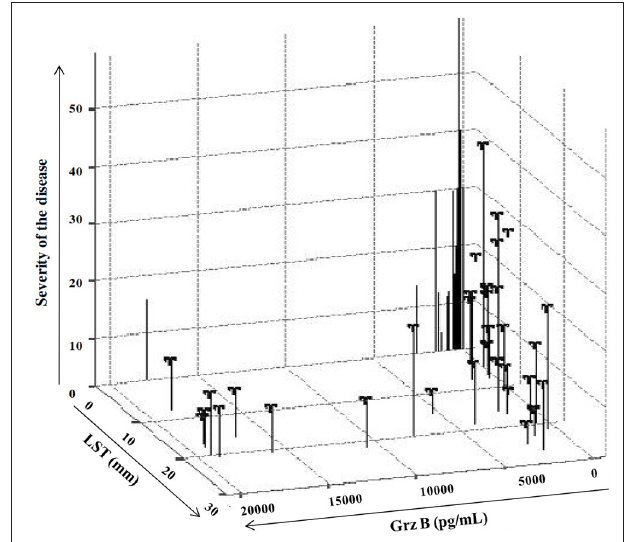
FIGURE 6 | Impact of the host’s immune response on the prevalence of ZCL. Expression of severity score in function of result of LST reactivity, expressed as diameter of induration (mm) and those of Grz B induction expressed in pg/mL.